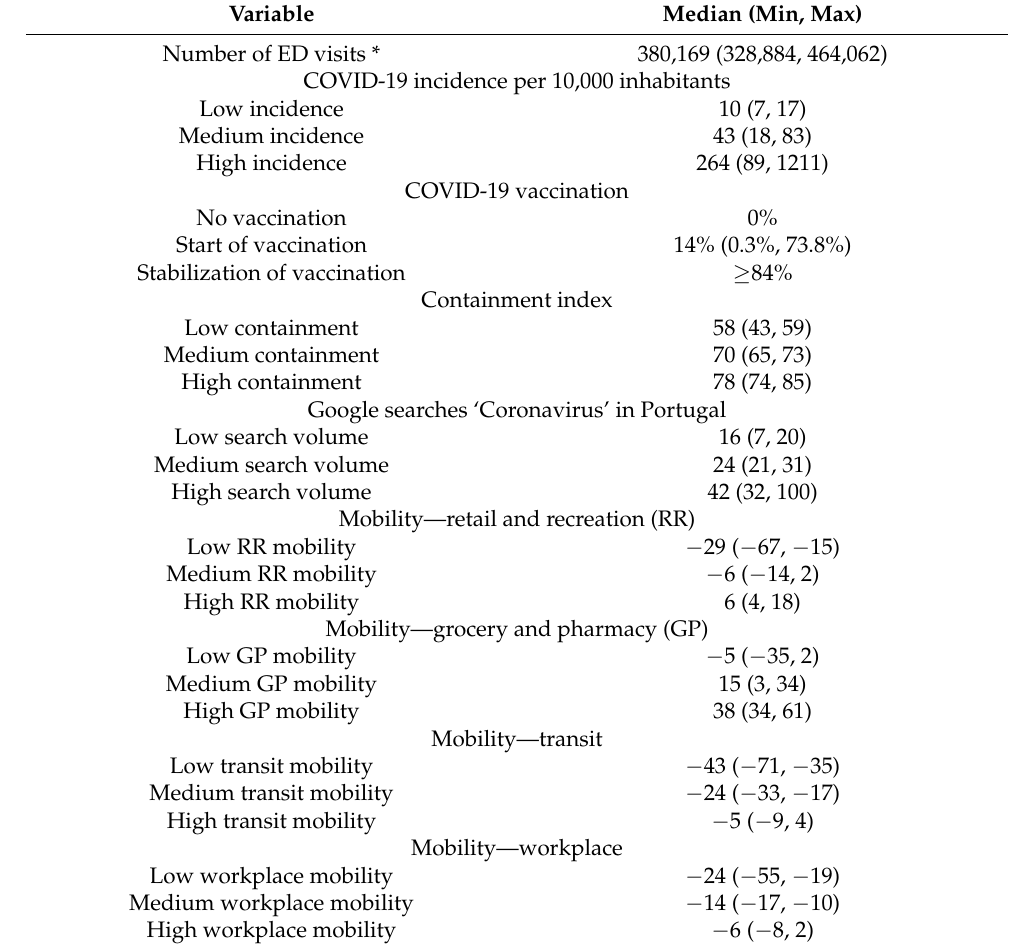
Table 1. Summary of the variables at national